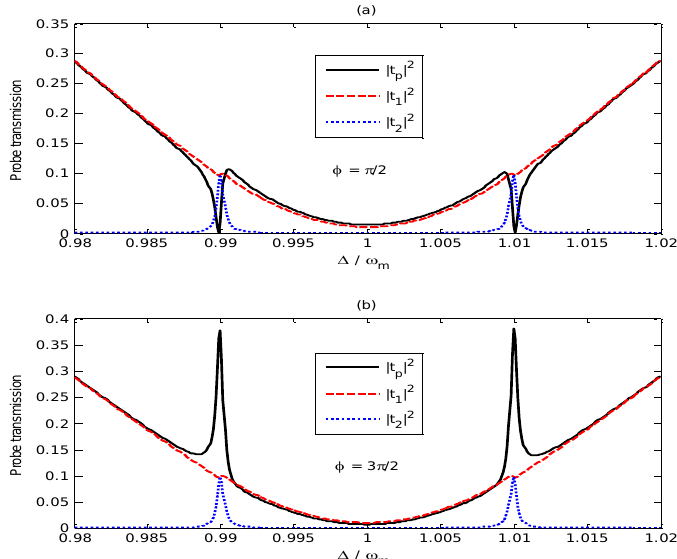
(cid:12) (cid:12) 2 , | t | 2 vary with the probe-pump field detuning ∆ / ω m for ( a ) φ = π /2 | 2 , | t Figure 4. Curves of (cid:12) t p (cid:12) 2 1 Figure 4. Curves of |𝑡 𝑝 | 2 , |𝑡 1 | 2 , |𝑡 2 | 2 vary with the probe-pump field detuning 𝛥 𝜔 𝑚 ⁄ for ( a ) 𝜙 = and ( b ) φ = 3 π /2. The other parameters are the same as those in Figure 2 except for ε c = 0.0055 ω 𝜋/2 and ( b ) 𝜙 = 3𝜋/2 . The other parameters are the same as those in Figure 2 except for 𝜀 𝑐 = 0.0055𝜔 𝑚 .